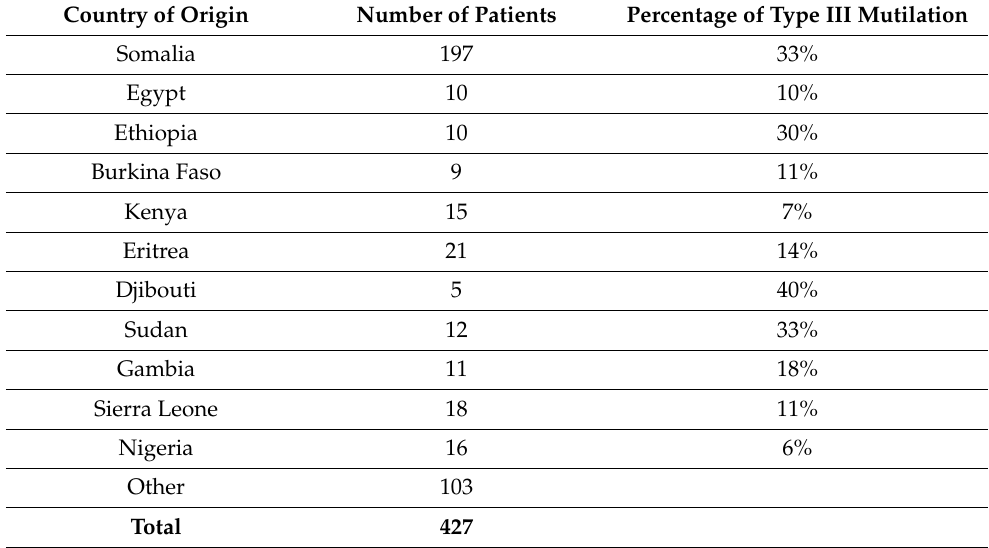
Table 2. Country of origin of all FGM patients referred and percentage of Type III mutilation. Country of